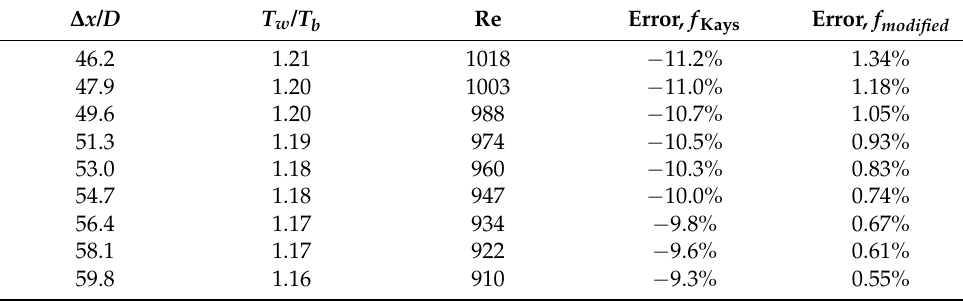
Table 11. Calculation error of modified f correlation for HeXe14.5 with case